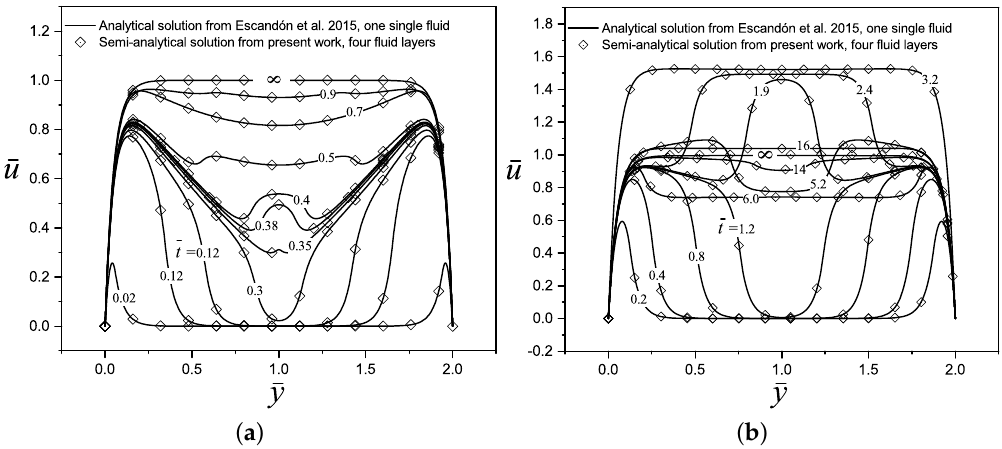
Figure 3. Dimensionless velocity profiles of an electroosmotic flow obtained by Escandón et al. [16] with n = 1, against the results of the present investigation with four fluid layers, n = 4 ( ¯ y 1 = 1/2, ¯ y 2 = 1.0, and ¯ y 3 = 3/2). The other parameters are ¯ ρ n = ¯ η n = ¯ (cid:101) n = 1, and ∆ ¯ ψ n = 0, for: ( a ) ¯ λ n = 0.12 and ( b ) ¯ λ n =